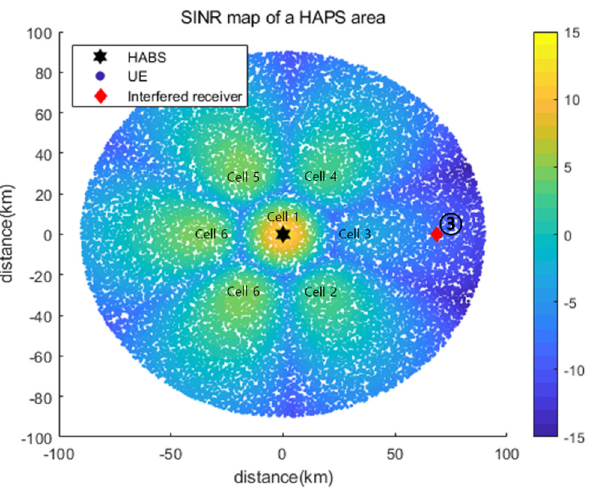
Figure 15. SINR map based on P c obtained using the proposed DQL-based power control algorithm for interfered receiver ③ . Table 6. Performance comparison for interfered receiver ③ .